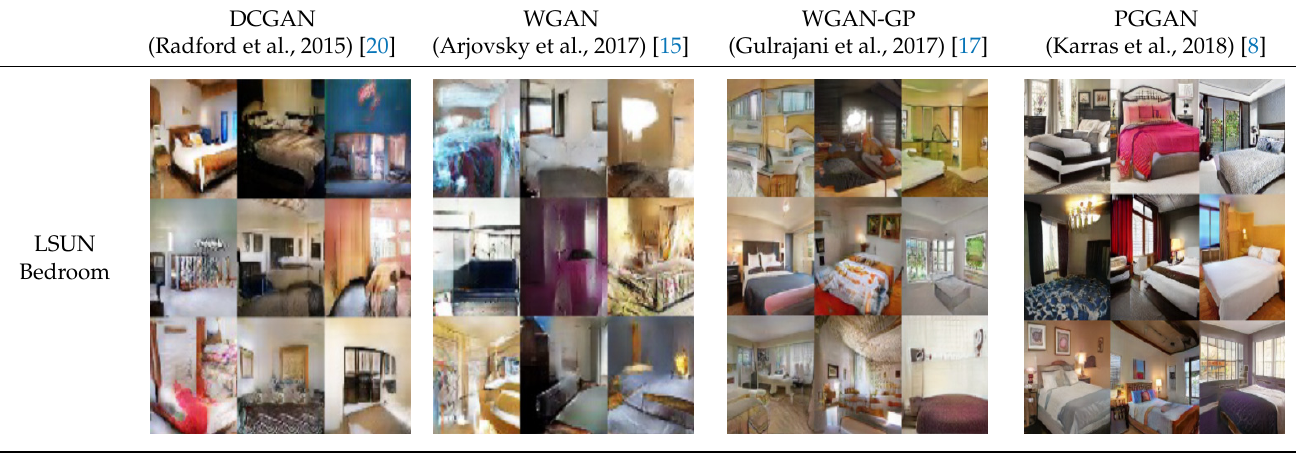
Table 2. Visual results of different models trained with the LSUN bedroom dataset. More results are presented in that paper.